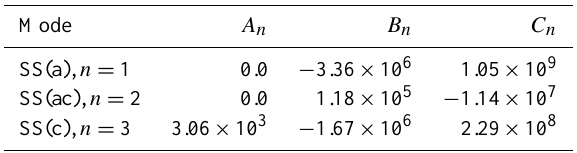
Table 2. Polynomial coefficients for the least square fitted modal sea salt number emission fluxes in Eq.